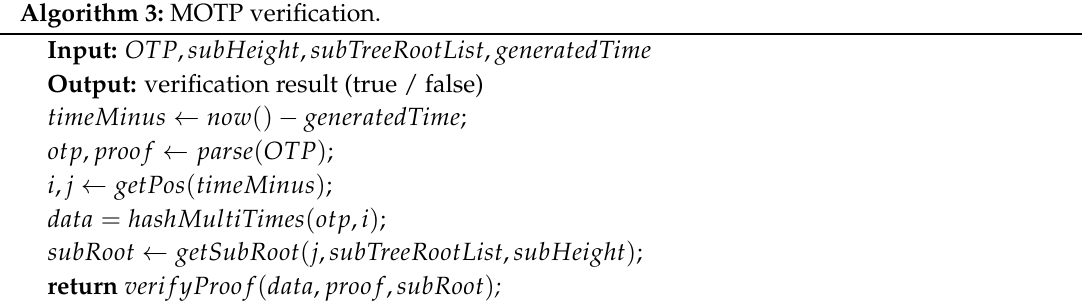
Algorithm 3: MOTP